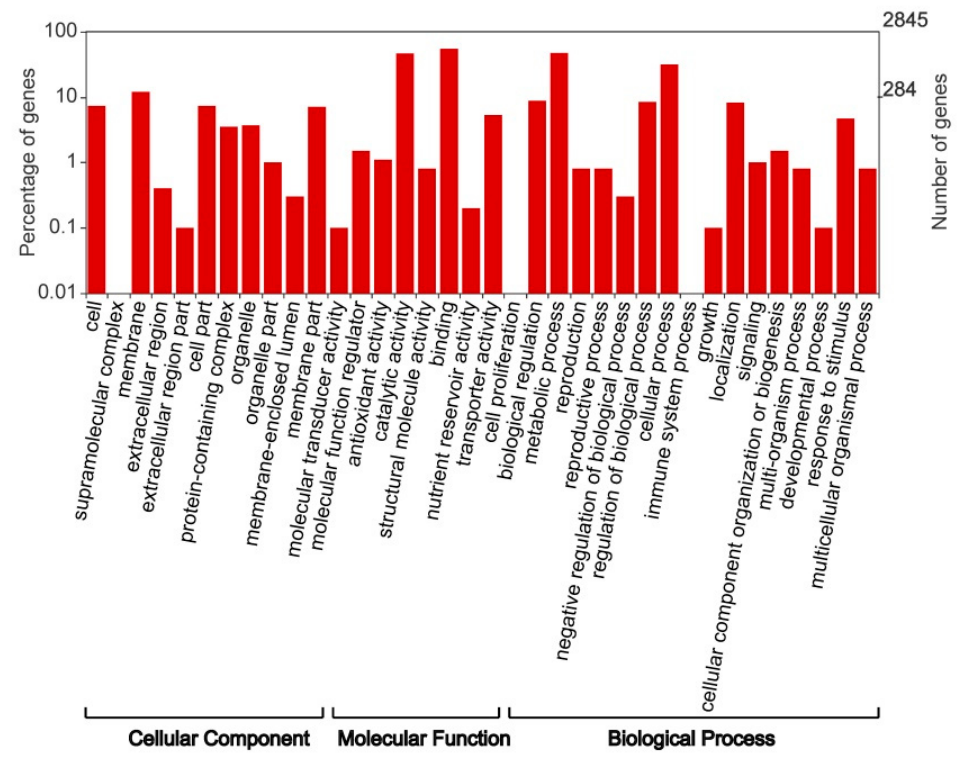
Figure 3. Comparison of GO term classifications of DG HP at the heading stage.